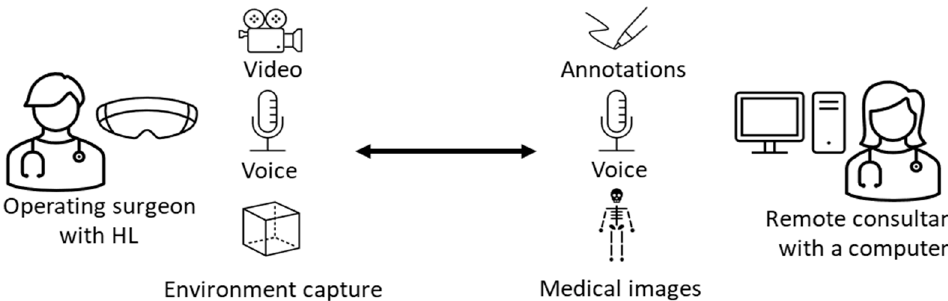
Figure 2. An overview of RISP with the data transmitted by the operating surgeon (video, voice and environment capture data) and the remote consultant (annotations, voice and medical images).